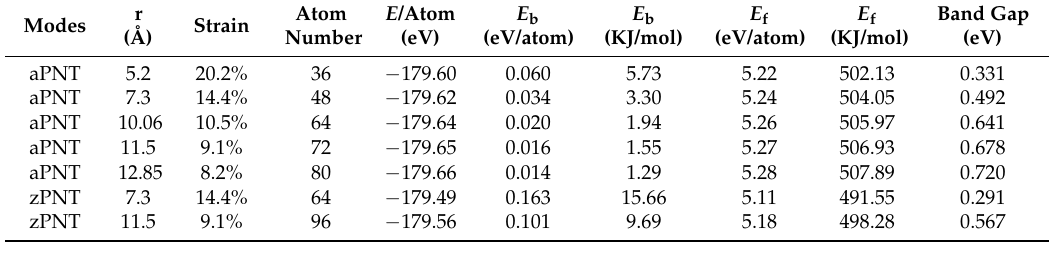
Table 2. Data of BP nanotubes with different bending directions and curvature radii. The energy per atom of planar monolayer BP ( E a ) is − 179.66 eV with a band gap of 0.763 eV. Modes